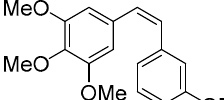
Figure 9. Molecular structures of combretastatins. 3.3. Styrylpyrones and Diarylheptanoids As noted above, flavonoids and allied compounds are formed via a combination of p -coumaroyl- CoA and three units of malonyl-CoA. This is the most common biosynthetic pathway for aromatic